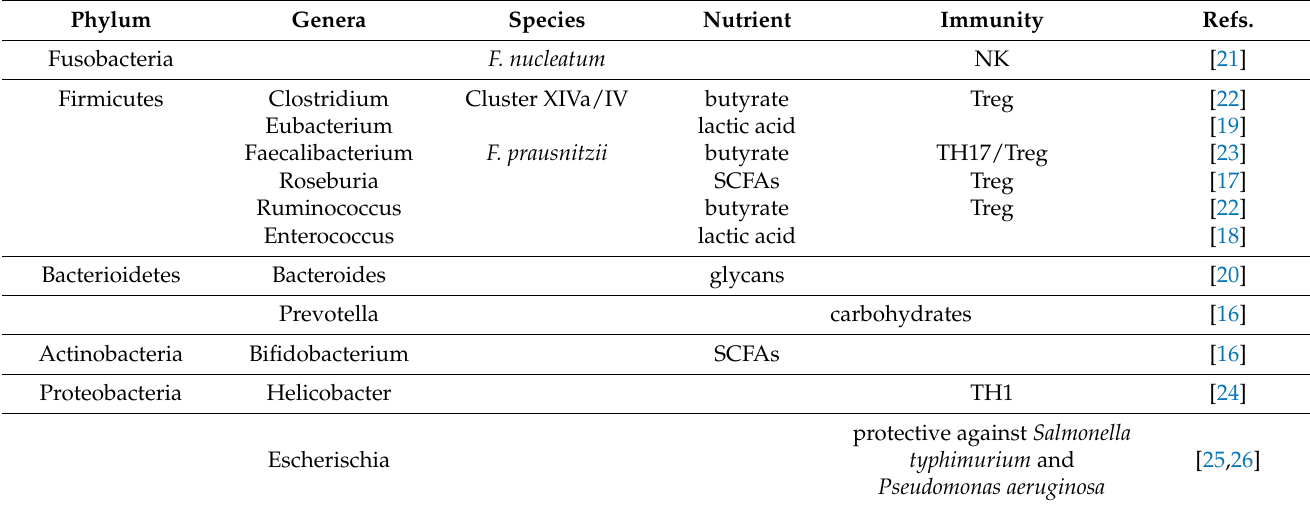
Table 1. Bacterial influence on nutrition and